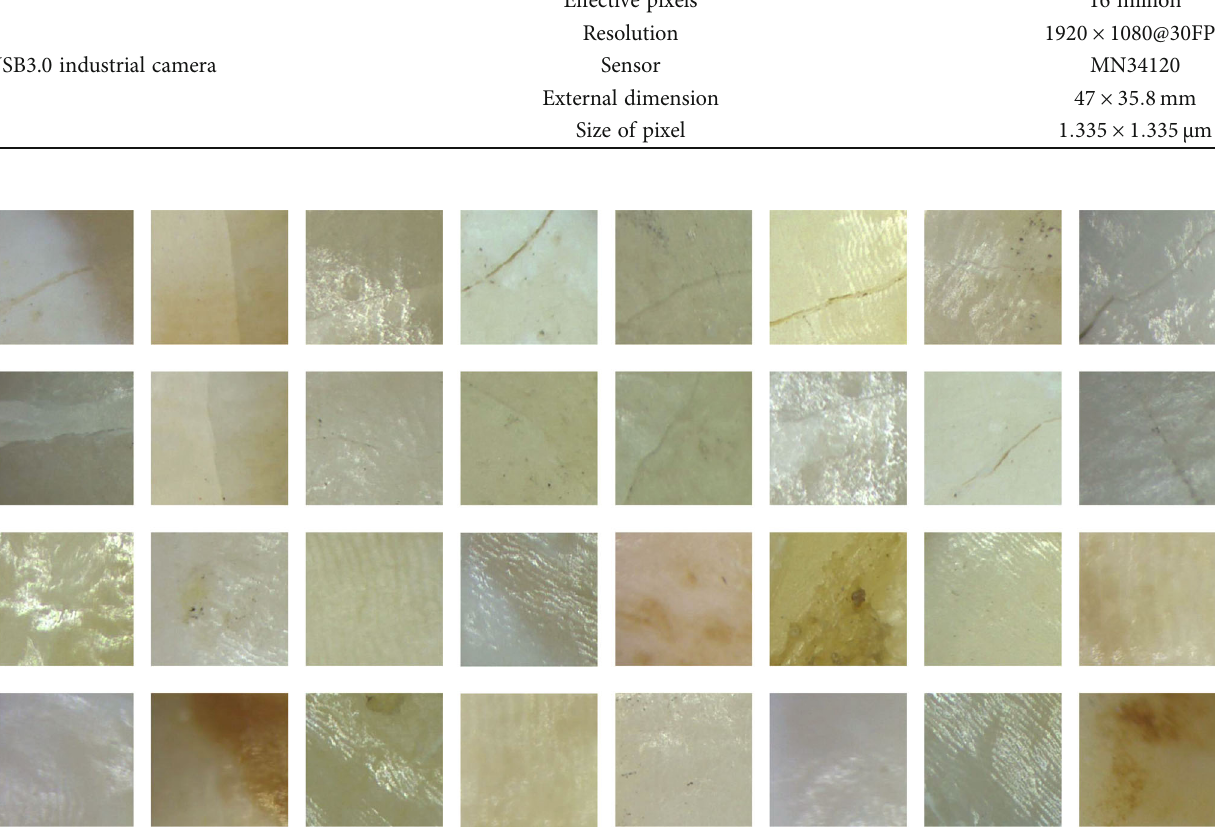
Figure 5: Sample display of partial dataset. Some cracks in images under various conditions (stained, overexplosion, a ff ected by other